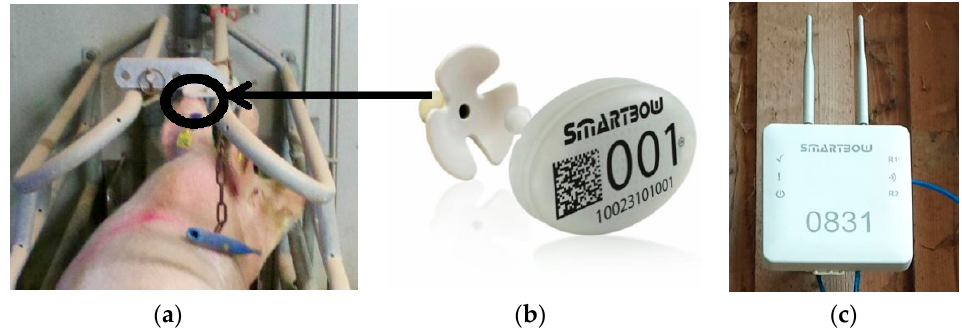
Figure 1. Sows were equipped with an ear tag ( a , b ) including an accelerometer. The tag actively sent their information to the receivers ( c ).